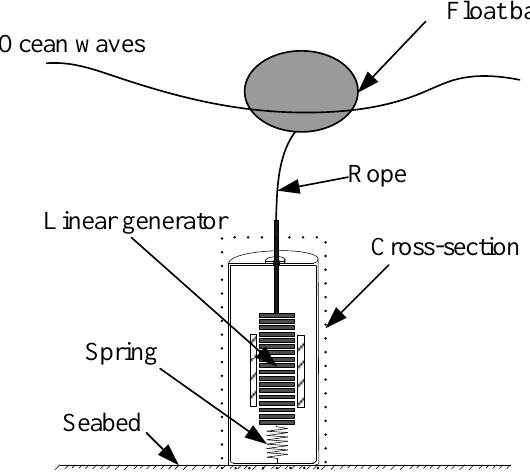
Figure 1. Structure of an ocean wave energy conversion device.